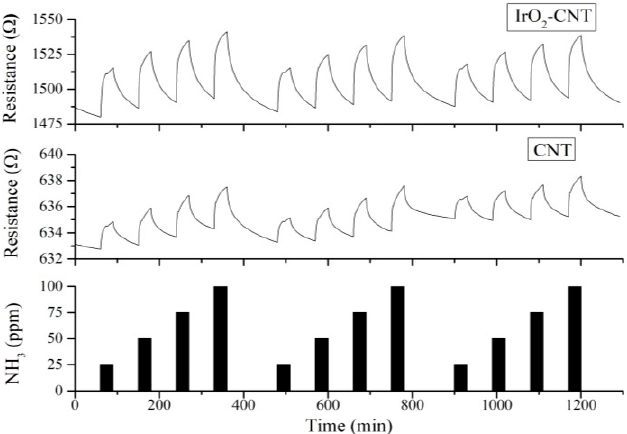
Figure 3. Example of the resistance response obtained for NH 3 detection at 100